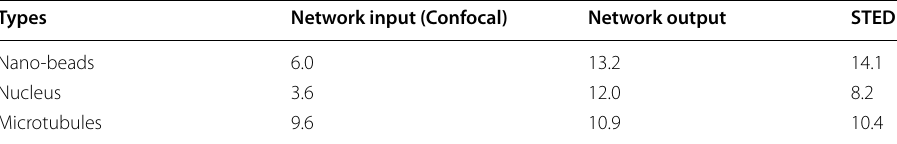
Table 1 Quantification of SNR improvement